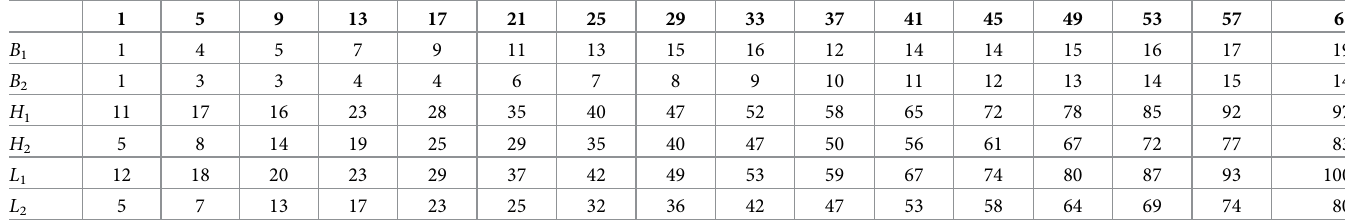
Table 3. The time cost of morphing model by Fourier transformation.